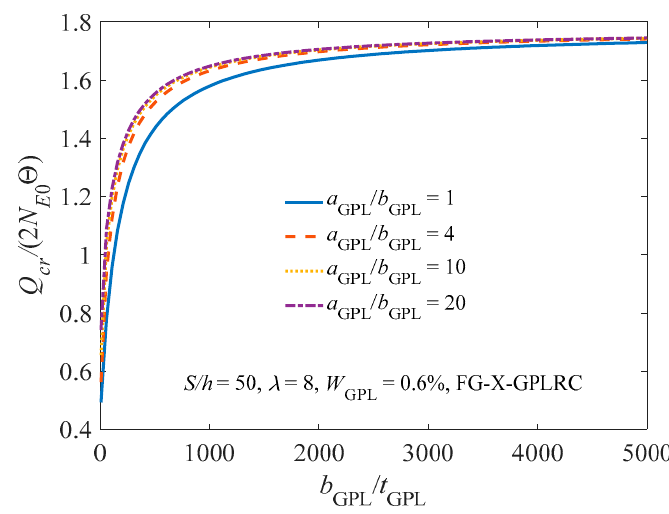
11 of 14 Figure 6. Effect of GPL weight fraction on buckling loads of the FG-GPLRC arch. Table 2. Limit point buckling load of FG-GPLRC arches. Patterns